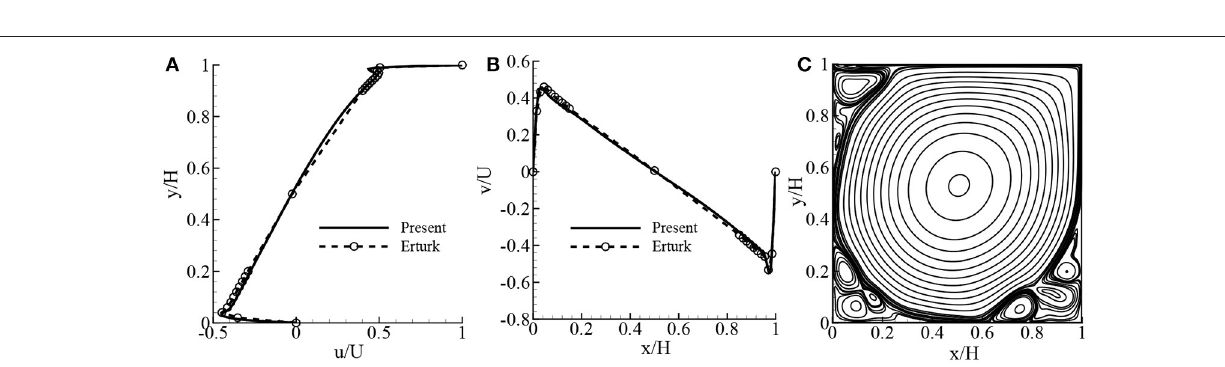
TABLE 2 | Comparison of the present results in terms of the average Nusselt number, Nu , with pure fluid results for Pr